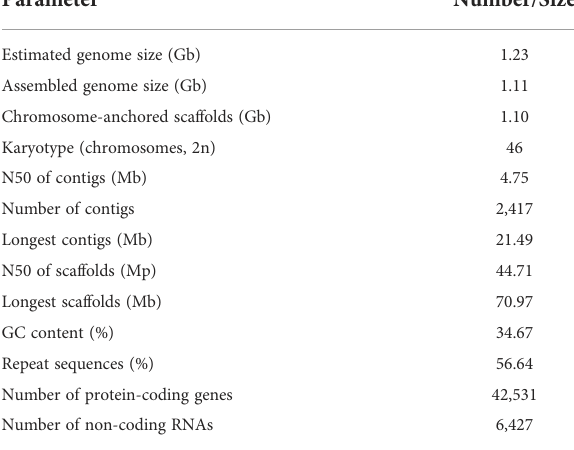
FIGURE 1 Circular diagram showing the characteristics of the S. oblata genome Gene density, LTR (Long terminal repeat transposon) density and DNA transposon density are 500kb window